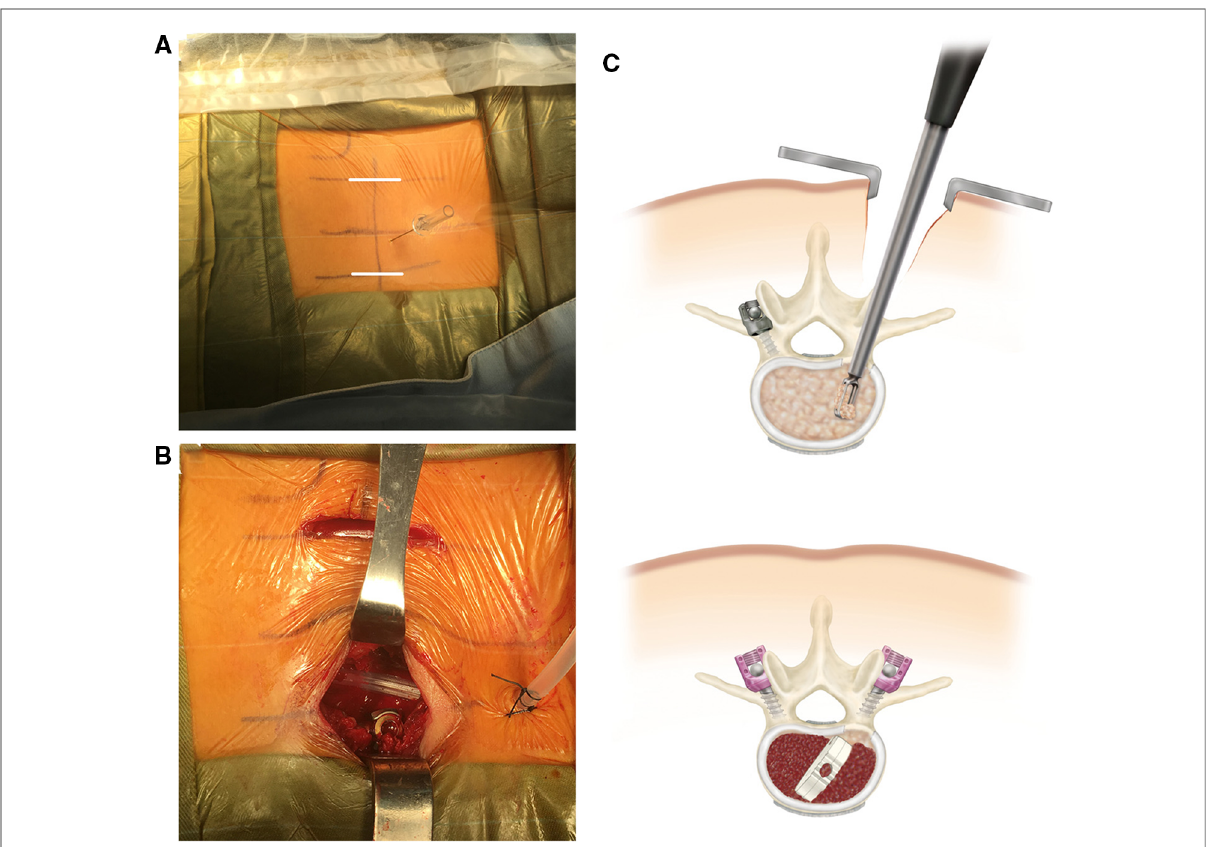
FIGURE 3 MIS-TLIF procedure ( A ) MIS-TLIF preoperative needle localization to determine the operative segment. The incision (white line) is located 2-3 cm away from the midline. ( B ) Bilateral small-incision MIS-TLIF, with the upper incision in the fi gure for pedicle screw placement via Wiltse approach and the lower incision for transforaminal decompression and intervertebral fusion. ( C ) Schematic diagram of the transverse MIS-TLIF approach and